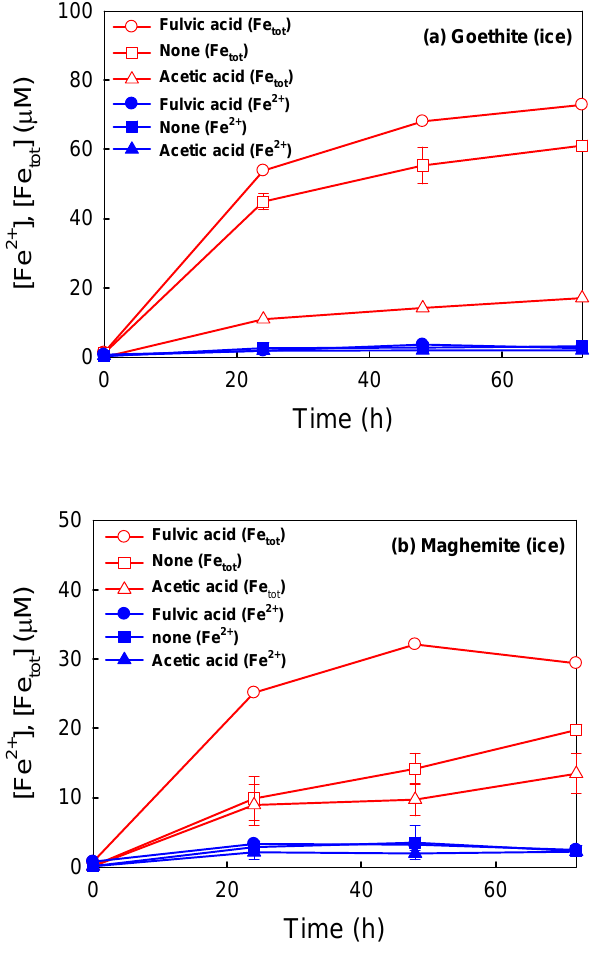
Fig. 3. The time profiles of dissolved iron (Fe 2+ and Fe tot ) generation from iron oxides in ice: (a) goethite and (b) maghemite. Experimental conditions: [ α -FeOOH or γ -Fe 2 O 3 ] i = 0.2 g L -1 , [fulvic acid] = 1 ppm, [acetic acid] = 6 mM, and pH i = 3.00 ± 0.05.